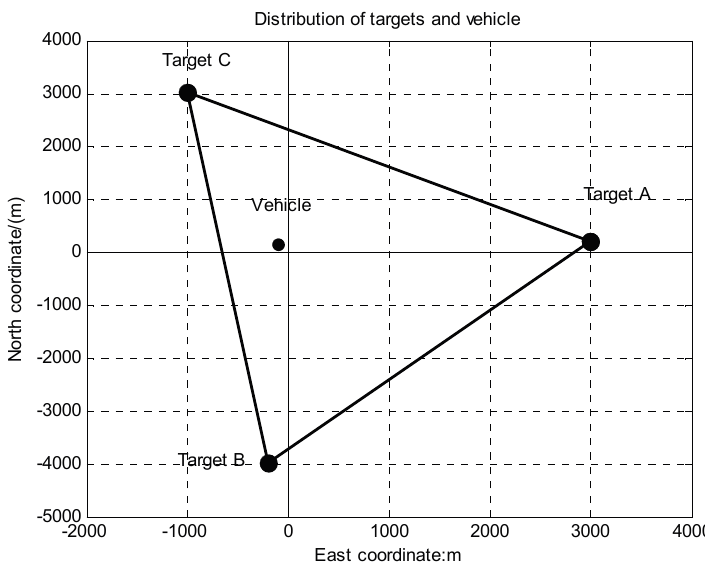
Figure 3. Distribution of targets and vehicle.